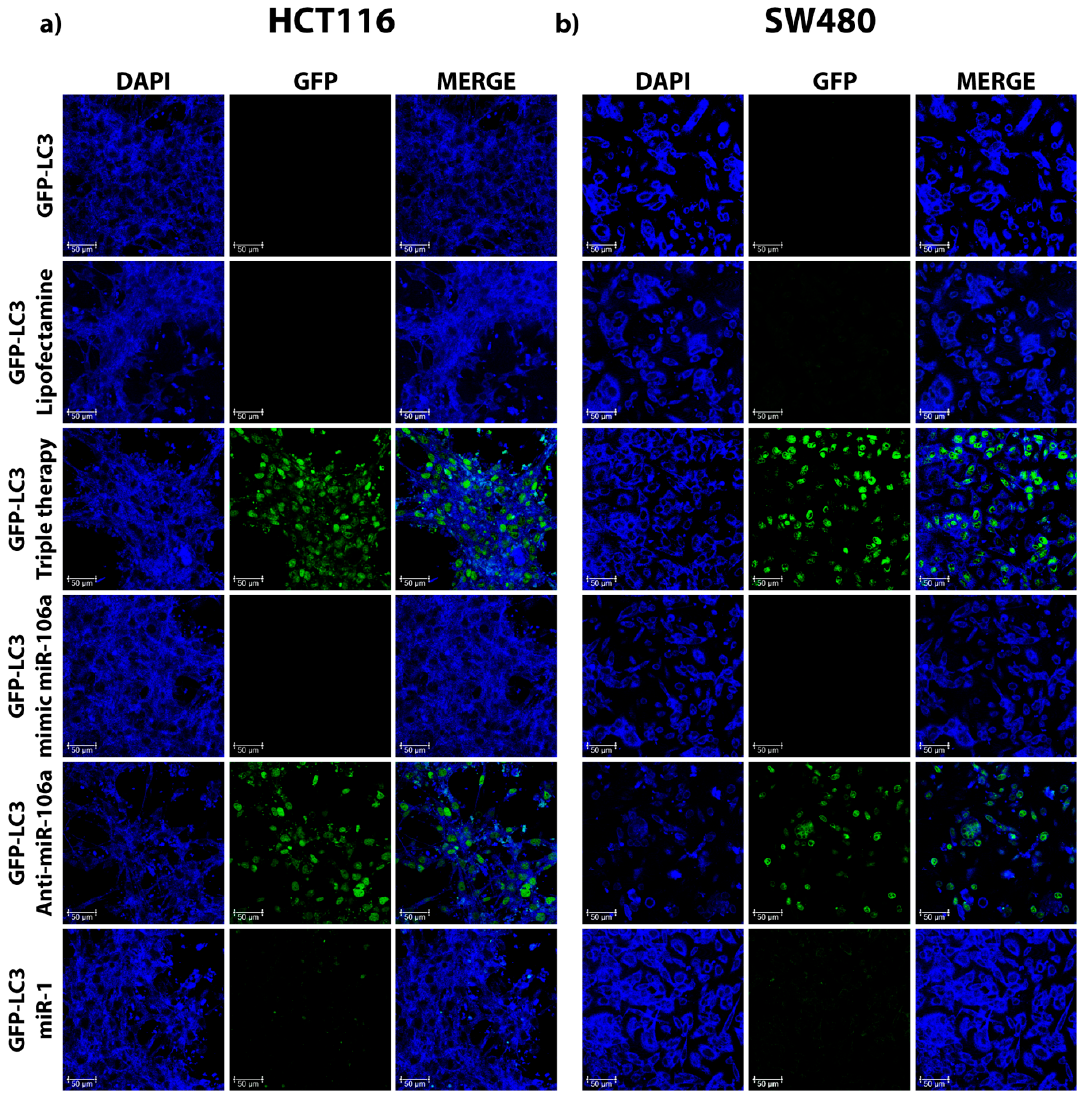
Figure 4. Autophagosome formation in colon cancer cell lines. ( a and b ) HCT116 and SW480 CRC cells were treated under different conditions, and they were transfected with LC3-GFP. Effects of lipofectamine, triple therapy, mimic miR-106a, and antimiR-106a on autophagy flux were observed by confocal microscopy. Images were obtained by confocal microscopy objective 40 x (Leica TCS-SP8, Germany); the experiment was done in duplicate. Scale bar of 50 μ m.